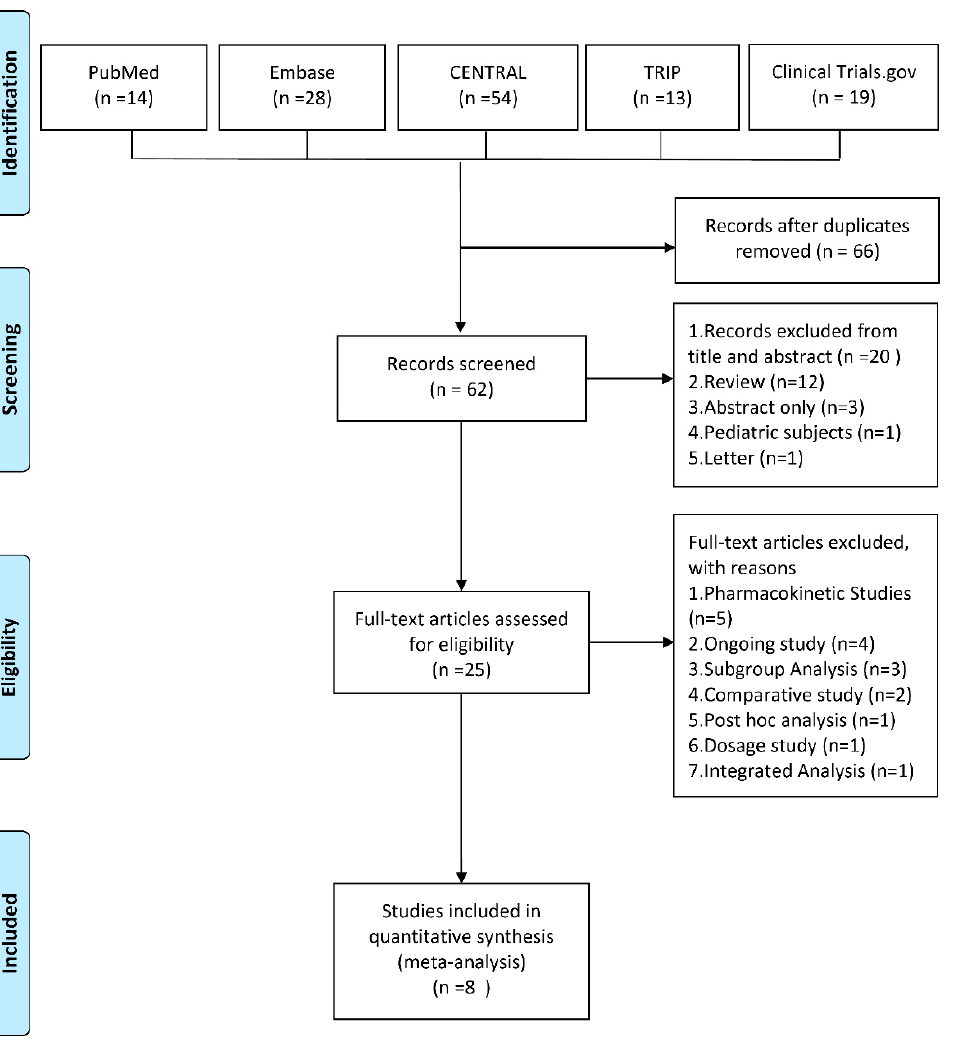
Figure 1. Algorithm of study selection. CENTRAL, Cochrane Central Register of Controlled Trials; TRIP, Turning Research into Practice.